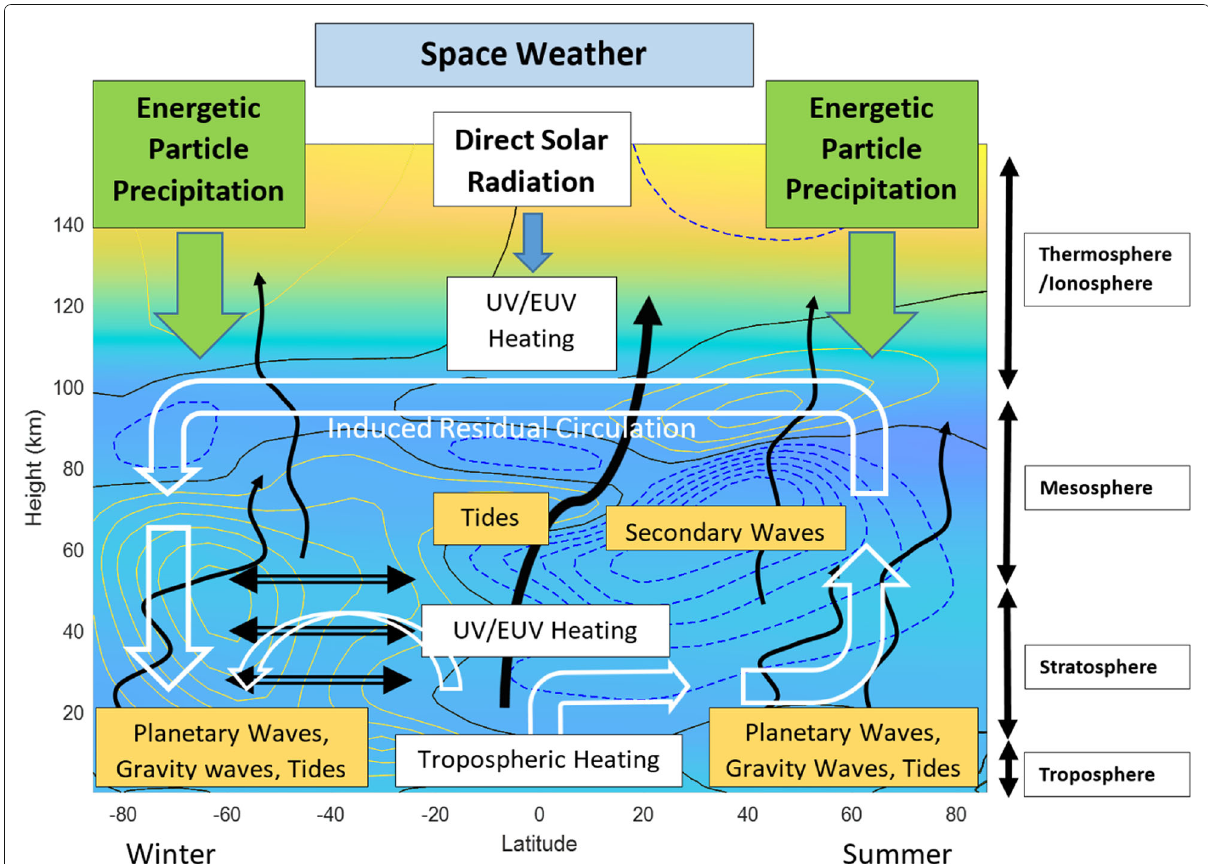
Fig. 2 The main drivers for coupling from above and below. The induced residual circulation is presented by white arrows. Black arrows represent the wave forcing and tides, as labeled. The color background represents the zonal mean temperature structure with blue indicating the coldest regions and yellow the warmest regions. The contour lines represent the zonal mean zonal wind structure (yellow is positive, i.e., eastward wind; dashed blue is negative, i.e. westward wind; black is the zero wind line). The radiative processes are in white, the elements of wave driving in orange, and downward particle precipitation in